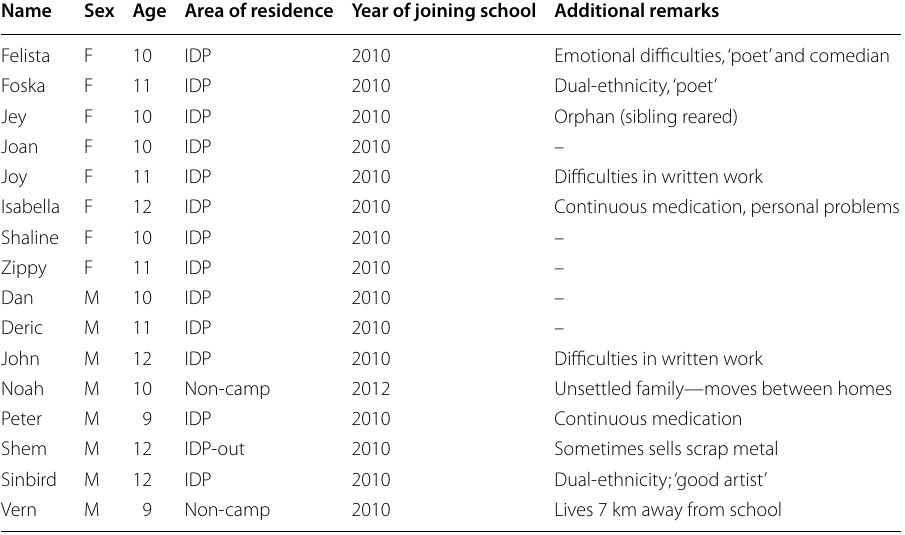
Table 2 Pupils’ profile information with additional